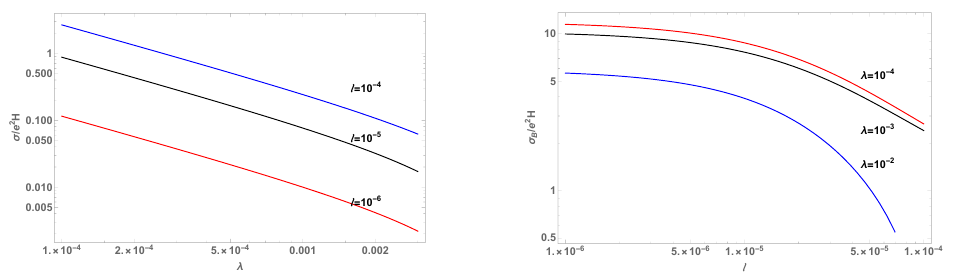
σ / e 2 H is plotted as a function of λ ( (cid:31) ), in the lowest Landau state n = 0 with B (cid:31) (cid:30)